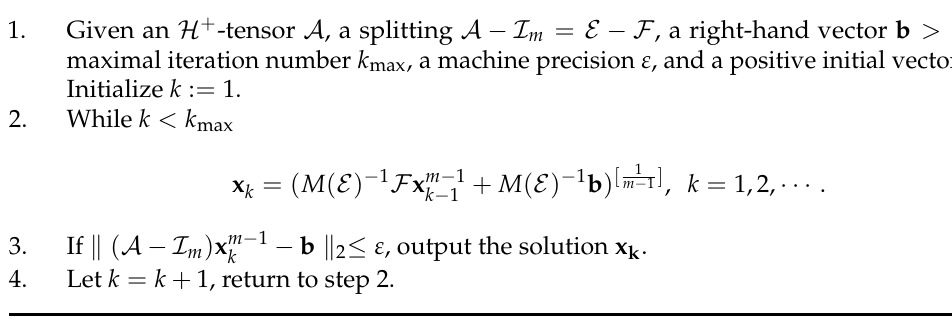
Algorithm 1 Tensor splitting AOR iterative